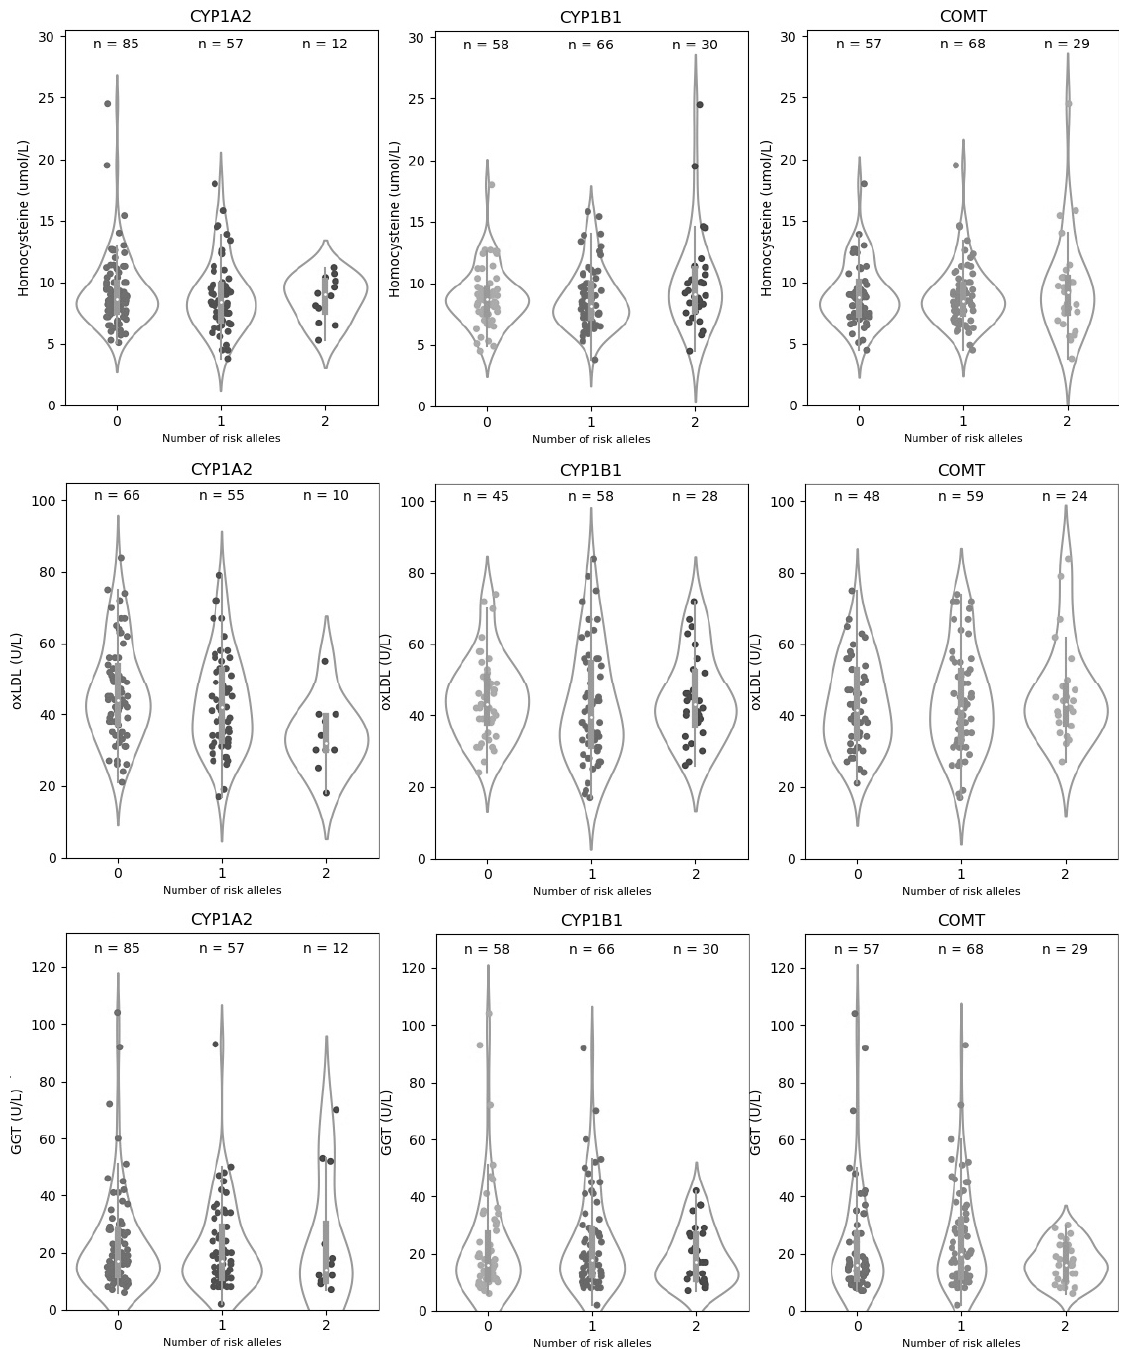
Figure 1. Distribution of homocysteine, oxLDL, and GGT values by genotype. The violin plots show the density plot and statistical summary of homocysteine, oxLDL, and GGT values for each genotype of the CYP1A1, CYP1B2, and COMT genes. The white dot of the box depicts the median, the thick gray bar in the center represents the interquartile range (IQR), which indicates the spread of the middle half of the distribution, and the thin line extending from the gray bar represents the rest of the distribution lying between the ± 1.5 × IQR range. The points represent the actual distribution of individual data. On each side of the gray line is a smoothed estimation of probabilities for new points, calculated using the Kernel Density Estimation, showing the distribution shape of the data. Wider sections of the violin plot represent a higher probability that members of the population will have the given value; the skinnier sections represent a lower